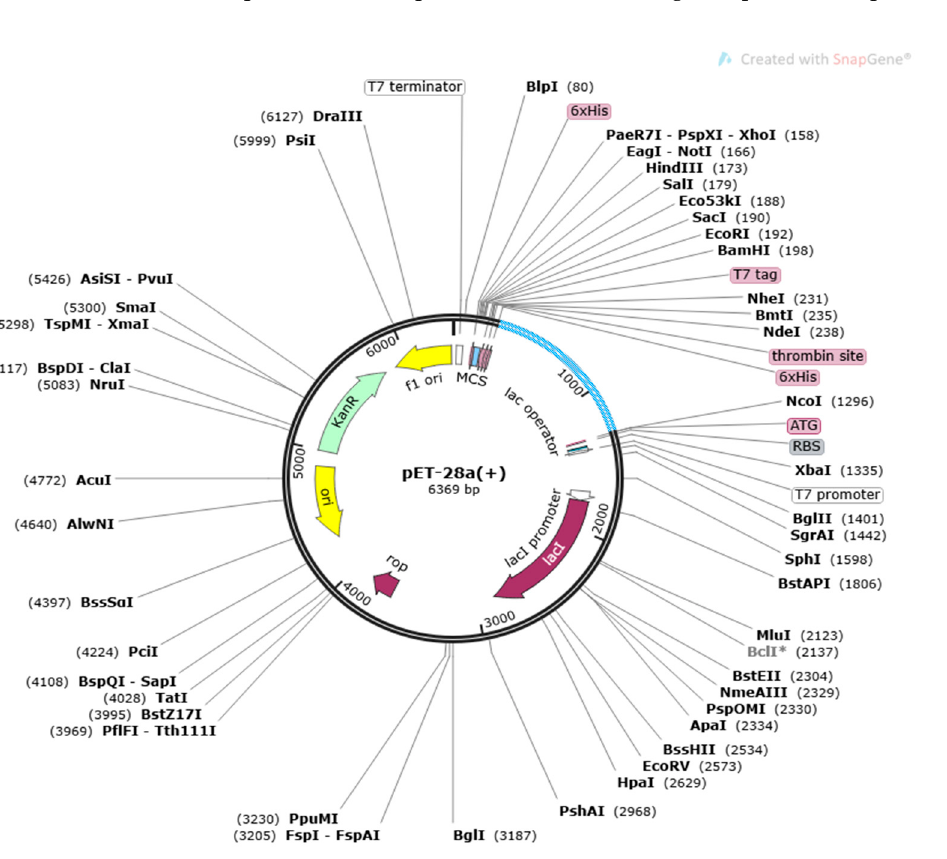
Figure 7. Cloning of vaccine construct into E. coli k12 strains pET28a vector.